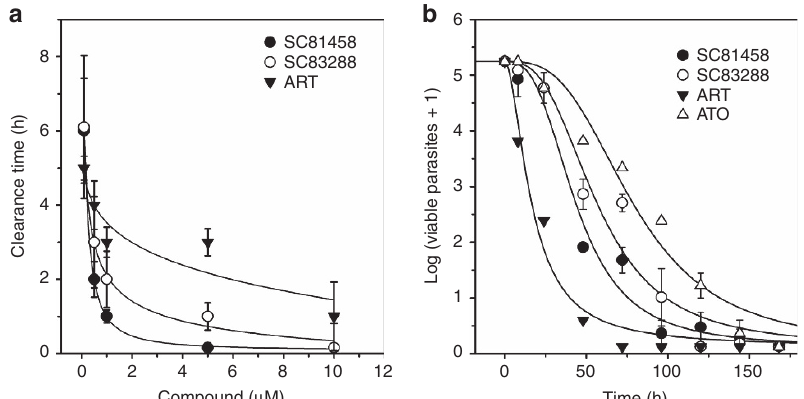
Figure 4 | In vitro killing kinetic profile of SC81458 and SC83288. ( a ) Concentration and exposure time-dependent clearance of a 0.5% parasitemia of trophozoites. The following drugs were investigated: artemisinin (ART, closed inversed triangles), SC81458 (closed circles) and SC83288 (open circles). ( b ) The graph shows the change in the number of viable parasites over time after exposure to ART (closed inversed triangles; 19nM), atovaquone (ATO, open triangles; 10nM), SC81458 (closed circles; 80nM), and SC83288 (open circles; 30nM) at a concentration corresponding to 10 times their respective IC 50 values. The mean ± s.e.m. are shown for at least four independent replicates.